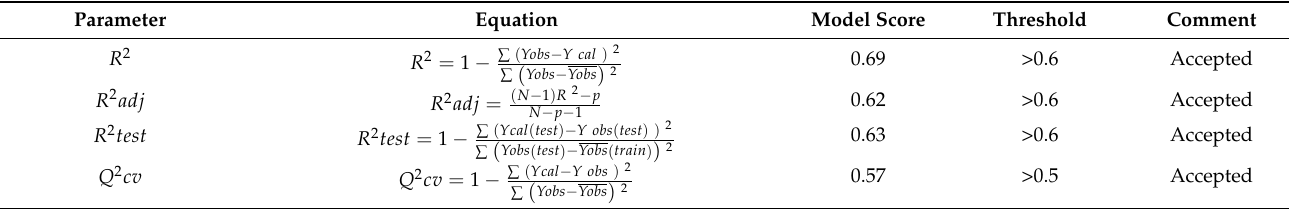
Table 7. Golbraikh and Tropsha statistical criteria to validate the designed QSAR